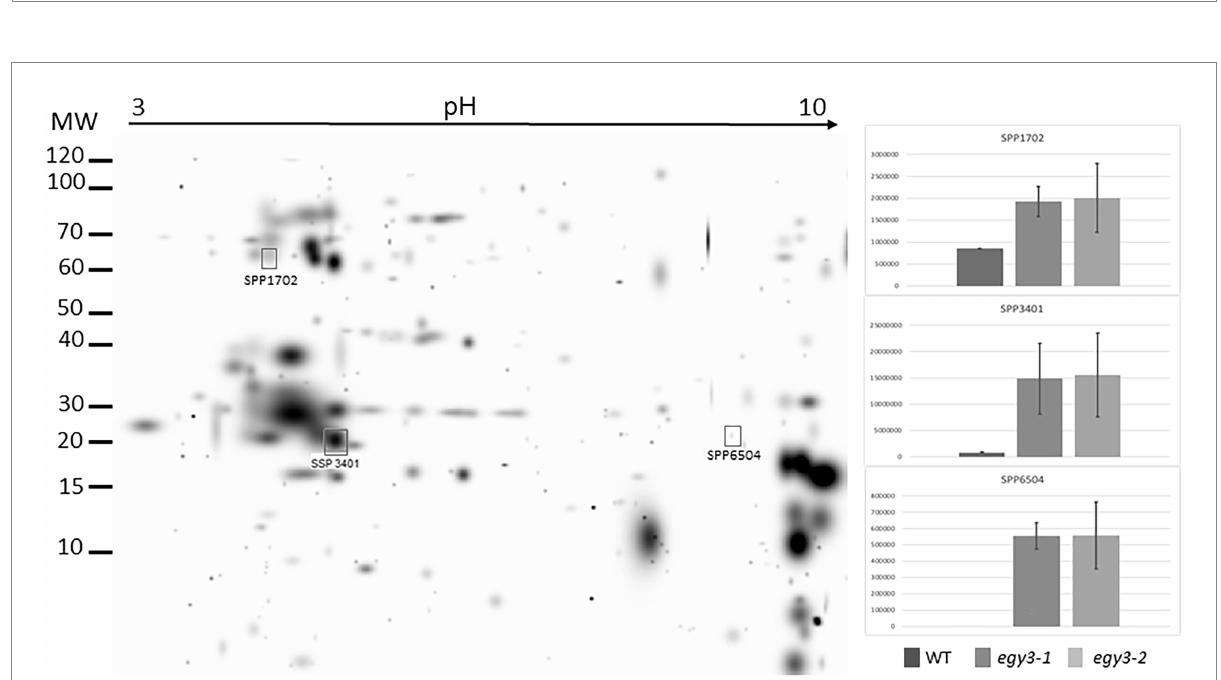
FIGURE 5 Two-dimensional electrophoresis gels of thylakoid membrane proteins isolated from wild-type (WT) and egy3-1 and egy3-2 lines, exposed to 3 h of 40 ° C. Proteins were separated using 2-D gel electrophoresis with IEF (pH 3–10) and detected with Coomassie Brilliant Blue staining. The image is digitally generated using the PDQuest Advanced 2-D Gel Analysis Software, (Bio-Rad, Hercules, United States) master gel, based on four electrophoretic separations made for two independent biological repetitions. The protein accumulation in the bar graphs was expressed in arbitrary units.